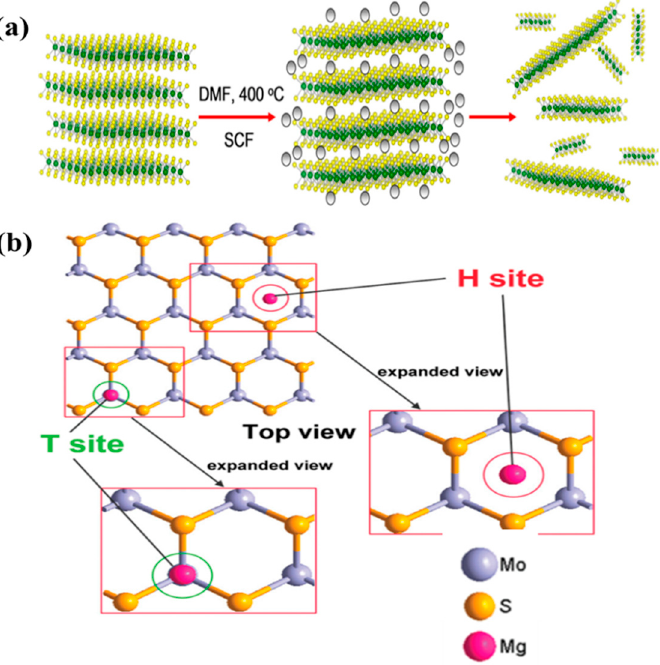
Figure 12. ( a ) Schematic diagram of the supercritical fluid (SCF) procedure to synthesize TMDs. Reprinted with permission from Truong et al. [90] Copyright 2017, American Chemical Society.( b )